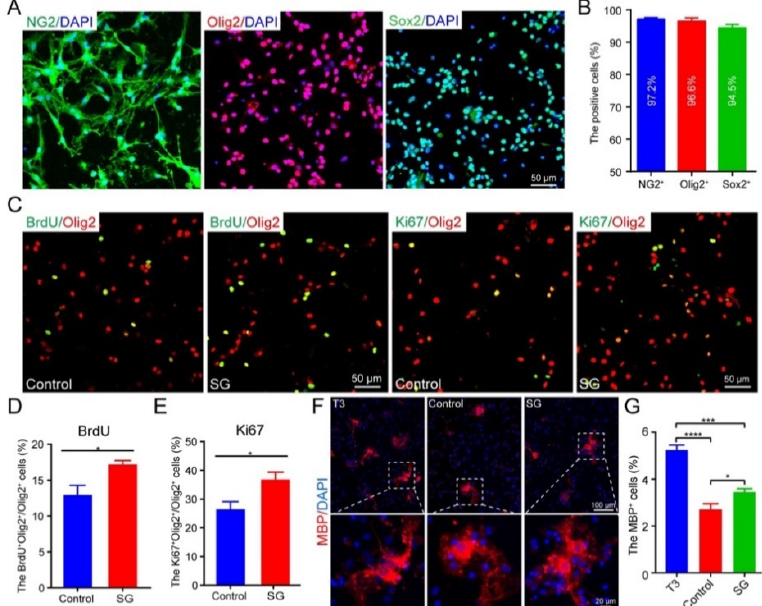
Figure 7. SCF + G-CSF treatment promotes the proliferation and differentiation of oligodendrocyte progenitor cells (OPCs) in vitro. ( A ) Representative images show that the primary cultured OPCs express NG2, Olig2, and Sox2. DAPI: nuclear counterstain. ( B ) The bar graph shows the percentage of NG2 + , Olig2 +, and Sox2 + cells in the primary cultured OPCs, indicating the high purity of the cultured OPCs. Sample size: n = 4. ( C ) Representative images show the proliferating OPCs (BrdU + Olig2 + or Ki67 + Olig2 + double-positive cells) at 24 h post-treatment. Scale bars in panels A and C: 50 µm. ( D , E ) Quantitative data of analysis of the number of BrdU + /Olig2 + ( D ) and Ki67 + /Olig2 + ( E ) proliferating OPCs in the medium control and SCF+G-CSF treatment groups. Unpaired Student’s t -test, * p < 0.05, n = 4. ( F ) Representative images show the differentiated oligodendrocytes (MBP + ) 48 h after treatment. Scale bar: 100 µm. Dashed boxes: selected cells with enlarged images. ( G ) A bar graph shows the percentage of MBP + oligodendrocytes in T3 treatment (positive control), medium control, and SCF+G-CSF treatment groups 48 h after treatment. SG: SCF+G-CSF. One-way ANOVA followed by Fisher’s LSD test. * p < 0.05, *** p < 0.001, **** p < 0.0001, n = 4.